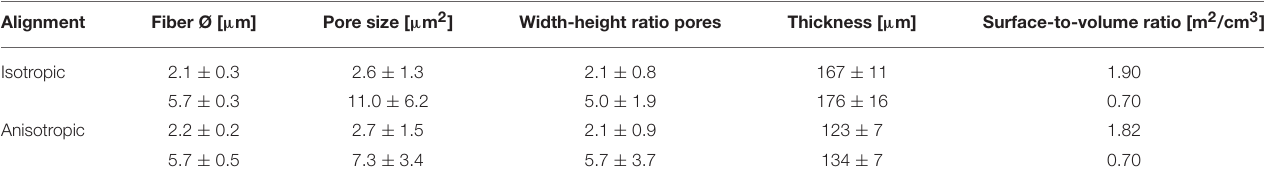
TABLE 4 | Fiber alignment, diameter, pore size and width-height ratio, thickness, and surface to volume ratio of the electrospun scaffolds.